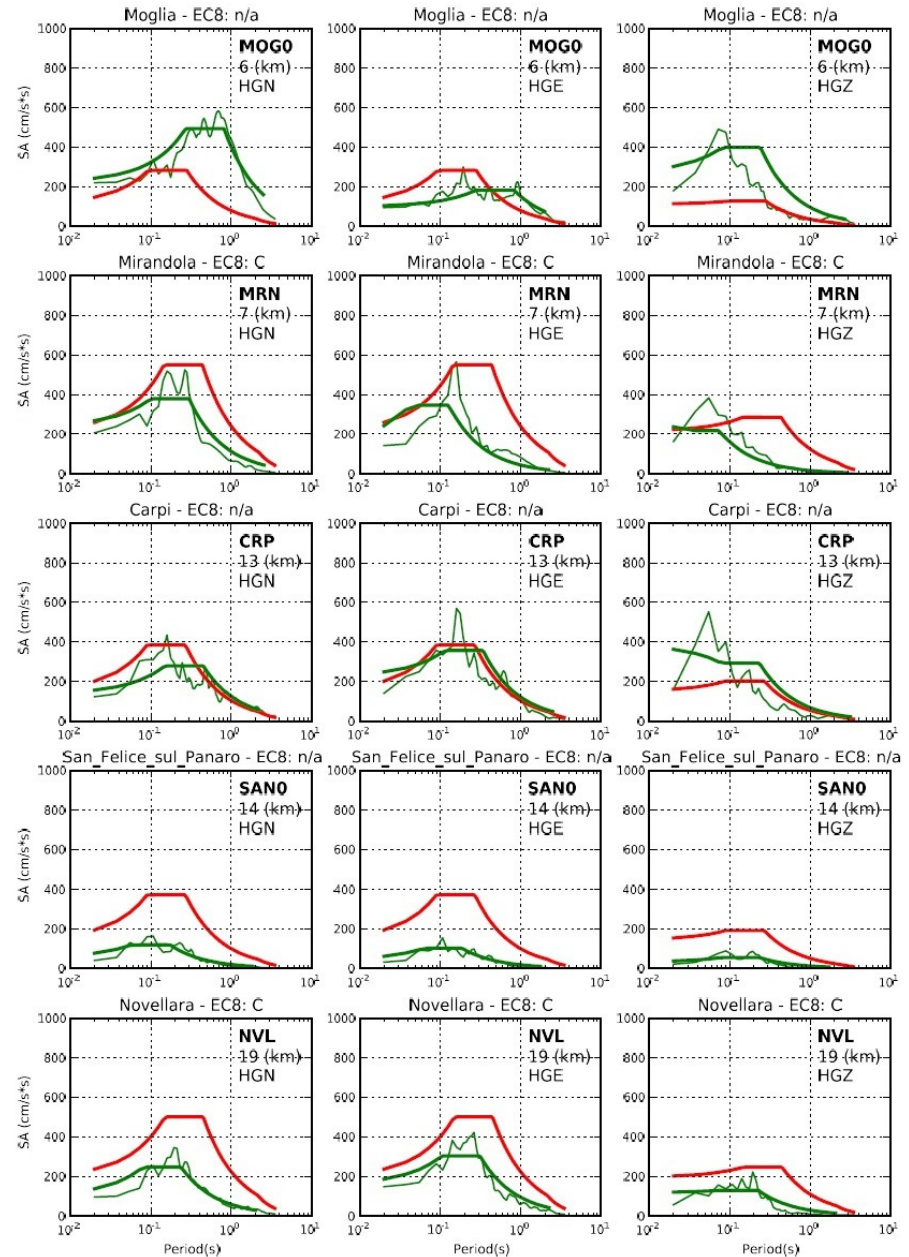
Figure 6. An example of the report page with the comparison of the SA (5% damping ratio given as thin green line), the recorded SA smoothed following the criteria suggested by Microzonation Working Group 2008 guidelines (thick green line), and the predicted SA for a return period of 475 years (i.e., a probability of excess of 10% in 50 years) as in NTC18 (red line) for the 29 May 2012 Emilia earthquake (Lat 44.886, Long 10.967, M l 5.3, M w 5.5, Seismic moment 3.92 × 10 17 Nm, Agency UniTS). In each row are reported the above-mentioned spectra for the three components (HGN, HGE, and HGZ) of the stations located at an epicentral distance between 6 km and 19